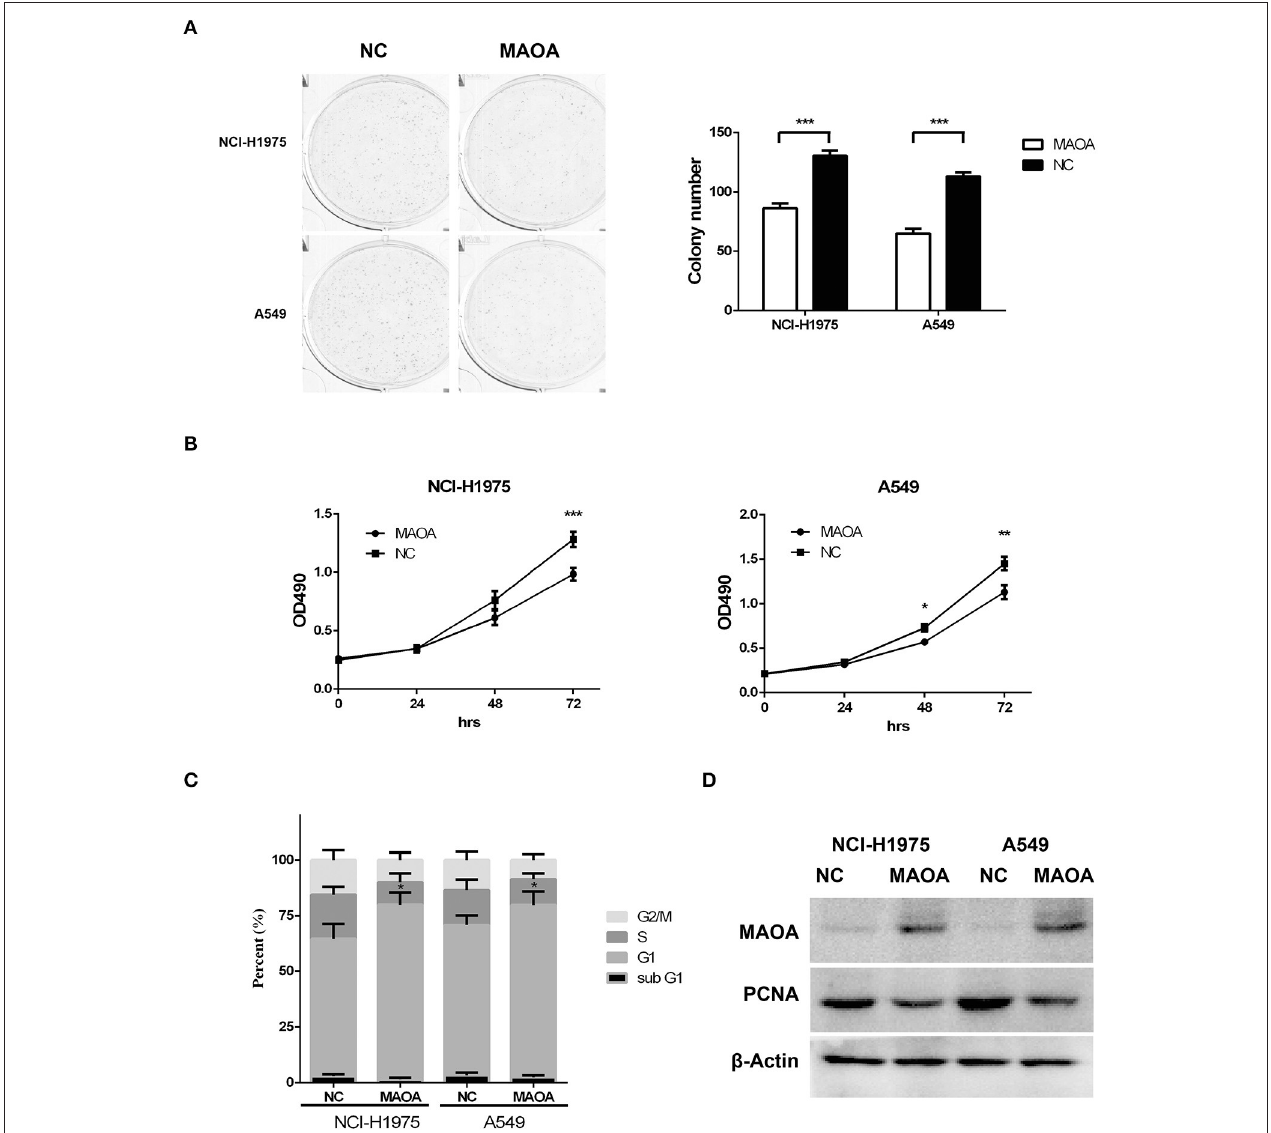
FIGURE 3 | Overexpressed MAOA affects LUAD cancer cell proliferation and growth in vitro . Colony formation (A) and MTT (B) assays performed to evaluate the effects of MAOA on LUAD cells (NCI-H1975 and A549). Flow cytometry (C) and Western blot (D) performed to analyze LUAD cell cycle and the G1/S cell cycle-related protein proliferating cell nuclear antigen (PCNA), respectively. Data are presented as mean + SD ( n = 3). * p < 0.05, ** p < 0.01 and *** p < 0.001, compared to the control